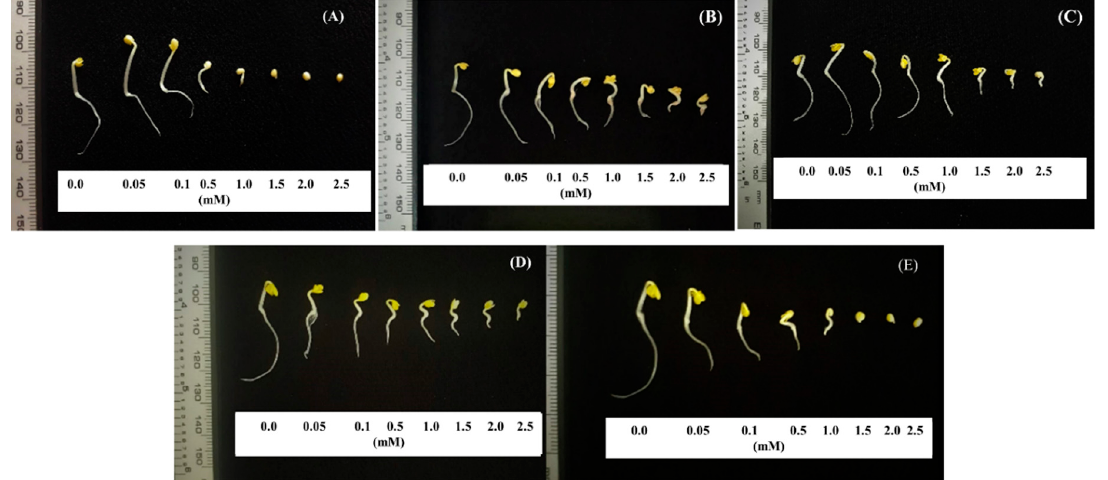
Figure 6. Effects of ( A ) salicylic acid, ( B ) vanillic acid, ( C ) 2,4-dimethoxybenzoic acid, ( D ) p- coumaric acid, and ( E ) cinnamic acid on shoot and root growth of mustard green seedlings following 48 h of incubation at various concentrations.